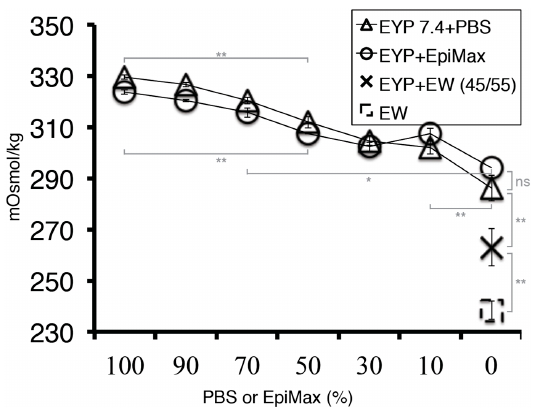
Figure A8. Graphical Representation of EYP’s or EYP7.4’s Osmolality as They were Diluted with PBS, EpiMax or EW. 10 μ L of the test samples were dropped on disc filter paper and analyzed in Vapor Pressure Osmometer (5520, VAPRO). With the most viscous samples (EYP or EYP 7.4), the filter papers were submerged in the liquid before they were transferred to the machine. Error Bars = Standard Error. For statistical analysis (grey lines) one-way ANOVA followed by Tukey’s Post-Hoc test with p -values = * < 0.05, ** < 0.01 was used. Materials 2020 , 13 , x FOR PEER REVIEW